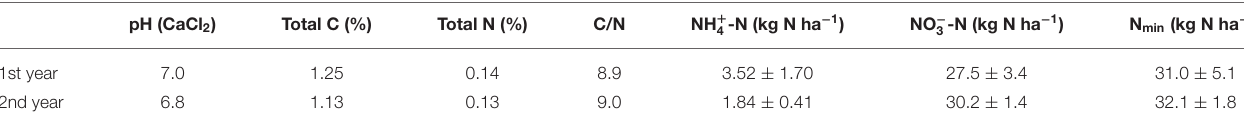
TABLE 2 | Soil characteristic at the beginning of the experiment spring 2016 (1st year) and 2017 (2nd year), mean mineral N (N min ) ( ± standard deviation ( n =